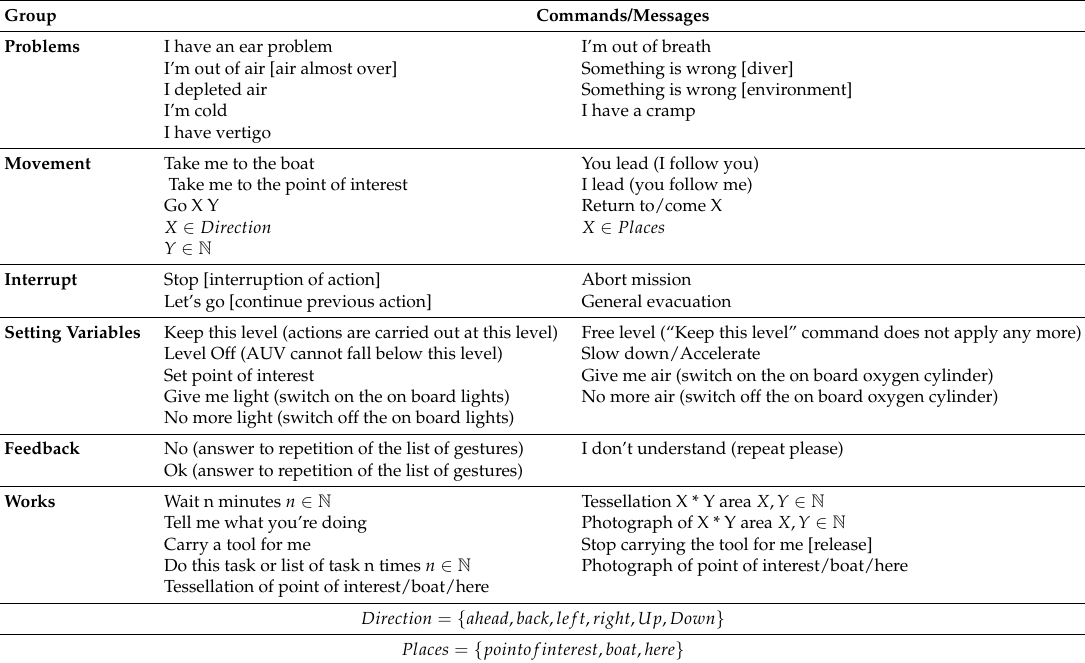
Table 1. List of commands as seen in